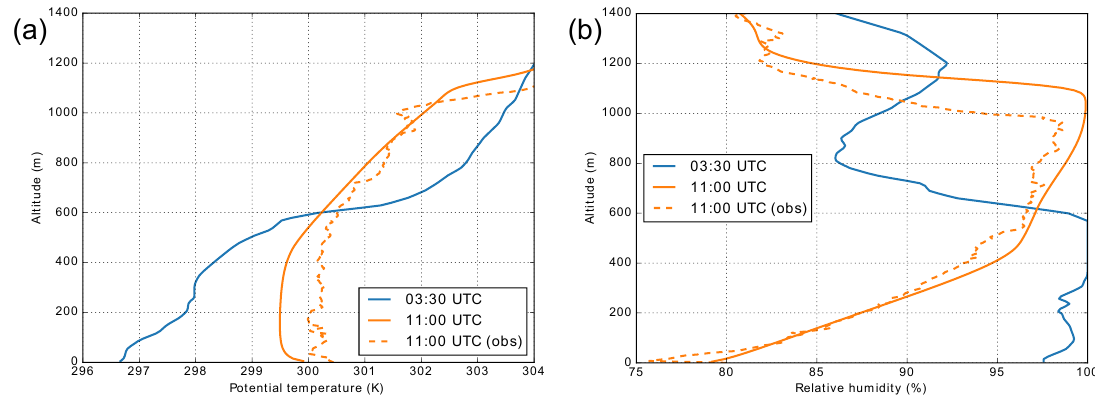
Figure 7. Simulated domain-average vertical profiles of (a) potential temperature and (b) relative humidity from the CASIM_NO_PROC simulation, calculated at 03:30UTC (blue) and 11:00UTC (orange). In each case the dashed orange line corresponds to the radiosonde profile from